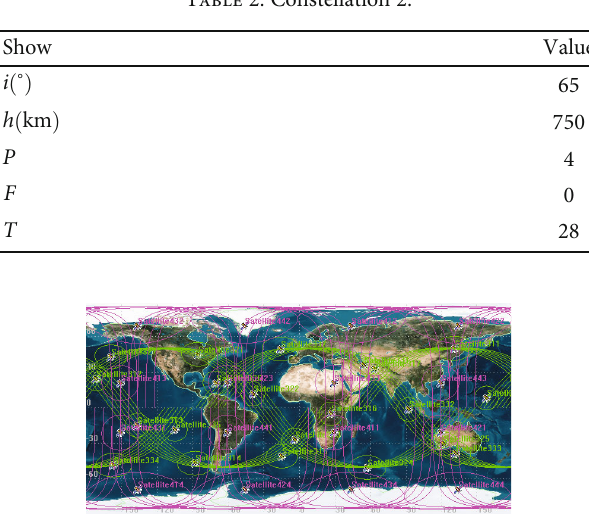
Figure 3: The coverage of hybrid